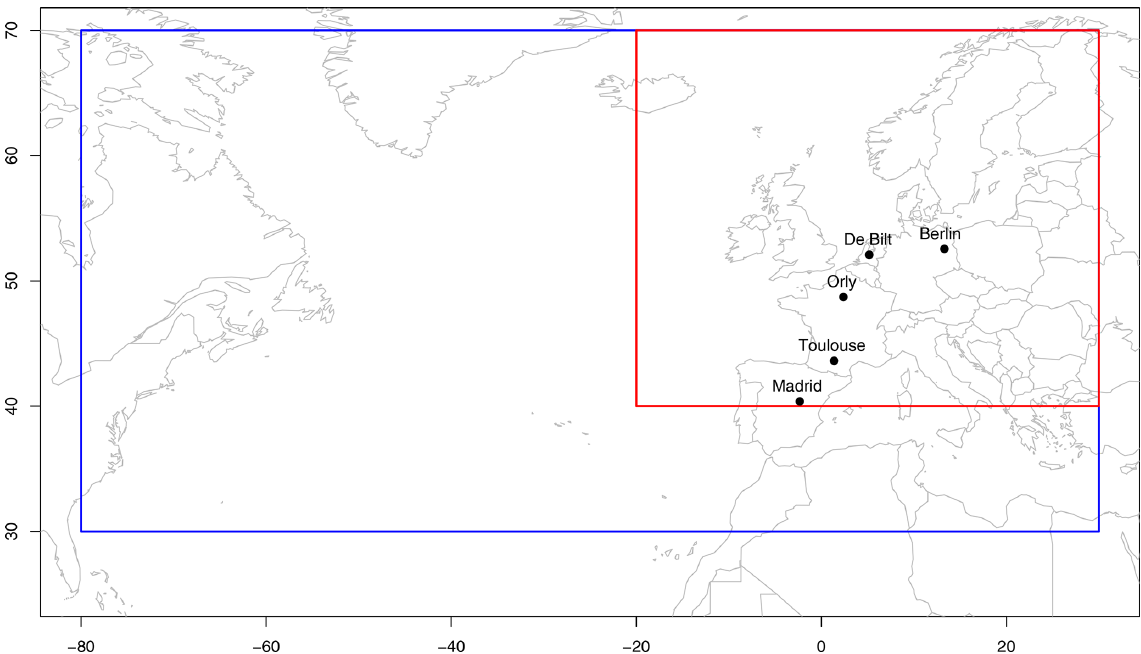
Figure 1. Location of five European stations. Longitudes are expressed in degrees east. Latitudes are expressed in degrees north. The red rectangle indicate the zone on which Z500 circulation analogues are computed. The blue rectangle indicates the region of pattern verification for Z500 and